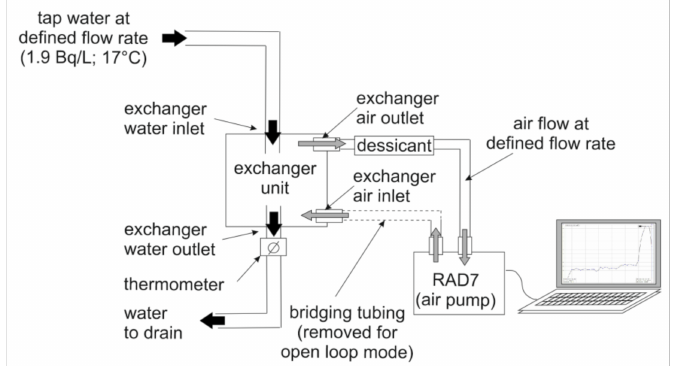
Figure 2. Experimental setup with exchanger unit either RAD AQUA or MiniModule; for experiments with air flow rates > 1 L / min up to three RAD7 (cid:48) s were attached set in